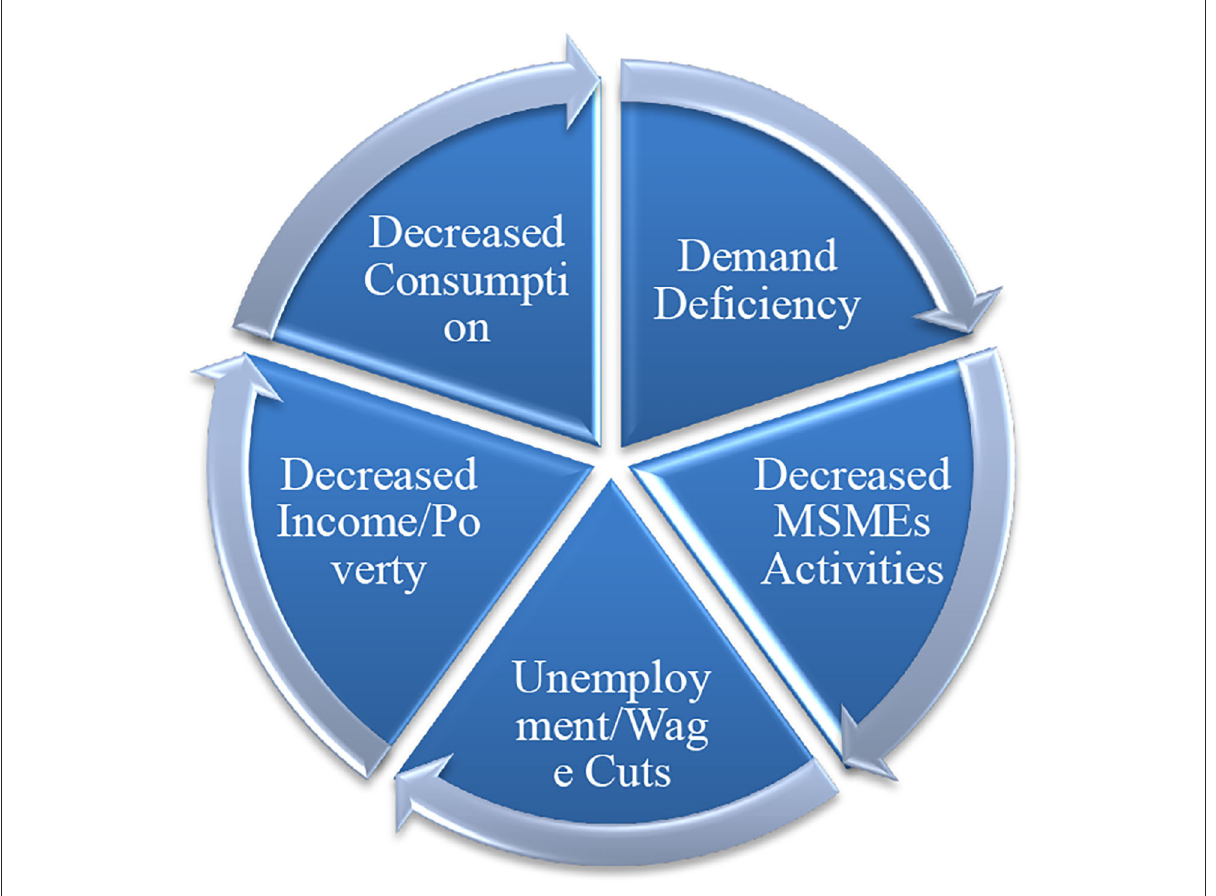
FIGURE1 Theoretical framework of the